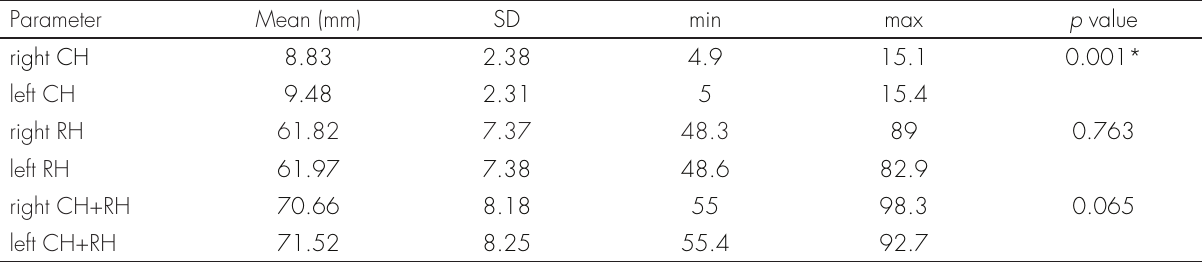
Table II. The mean, standard deviation, minimum, maximum and p values of the condylar, ramal and condylar+ramal height measurement for the left and right sides.